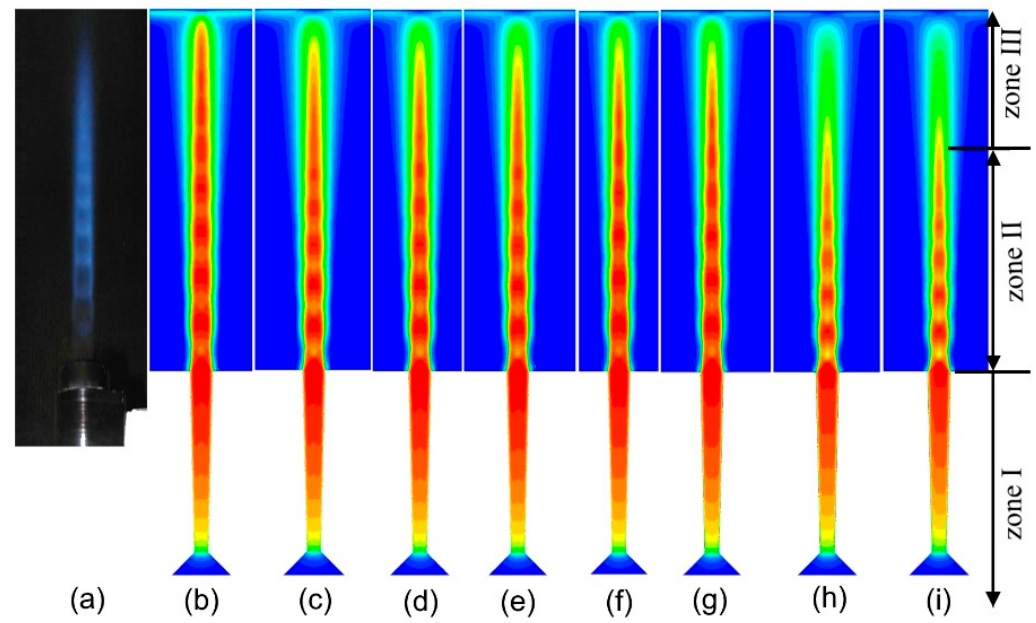
Figure 9. The flame of the actual spray gun and the partial contours of the airflow velocity: ( a ) actual spray gun, ( b - i ) experimental scheme corresponding to Table 1.